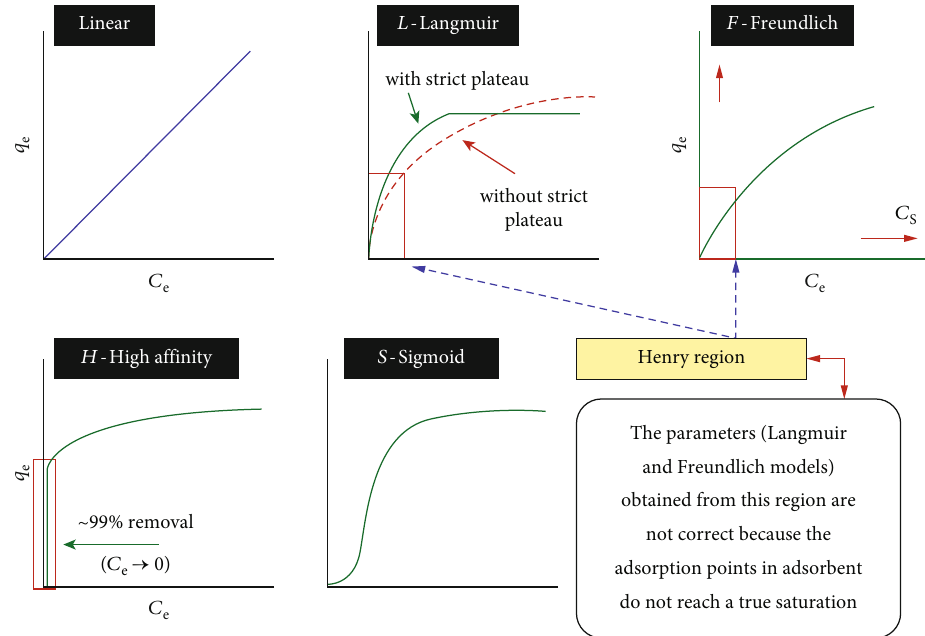
Figure 3: Di ff erent shapes of the adsorption isotherms classi fi ed by Moreno-Castilla